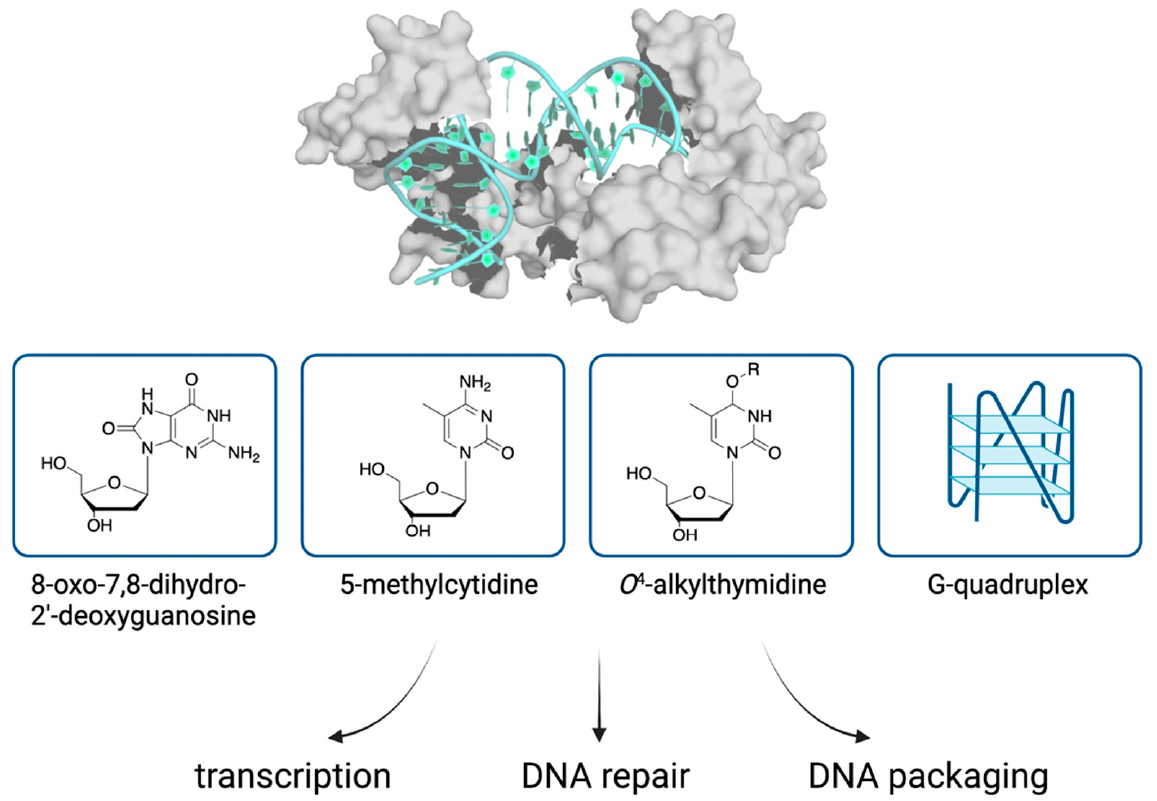
Figure 2. Binding of TFAM to DNA modifications and implications on the organization and transactions of mitochondrial DNA. TFAM (PDB: 3TQ6) and DNA are shown in surface and carton views, respectively.